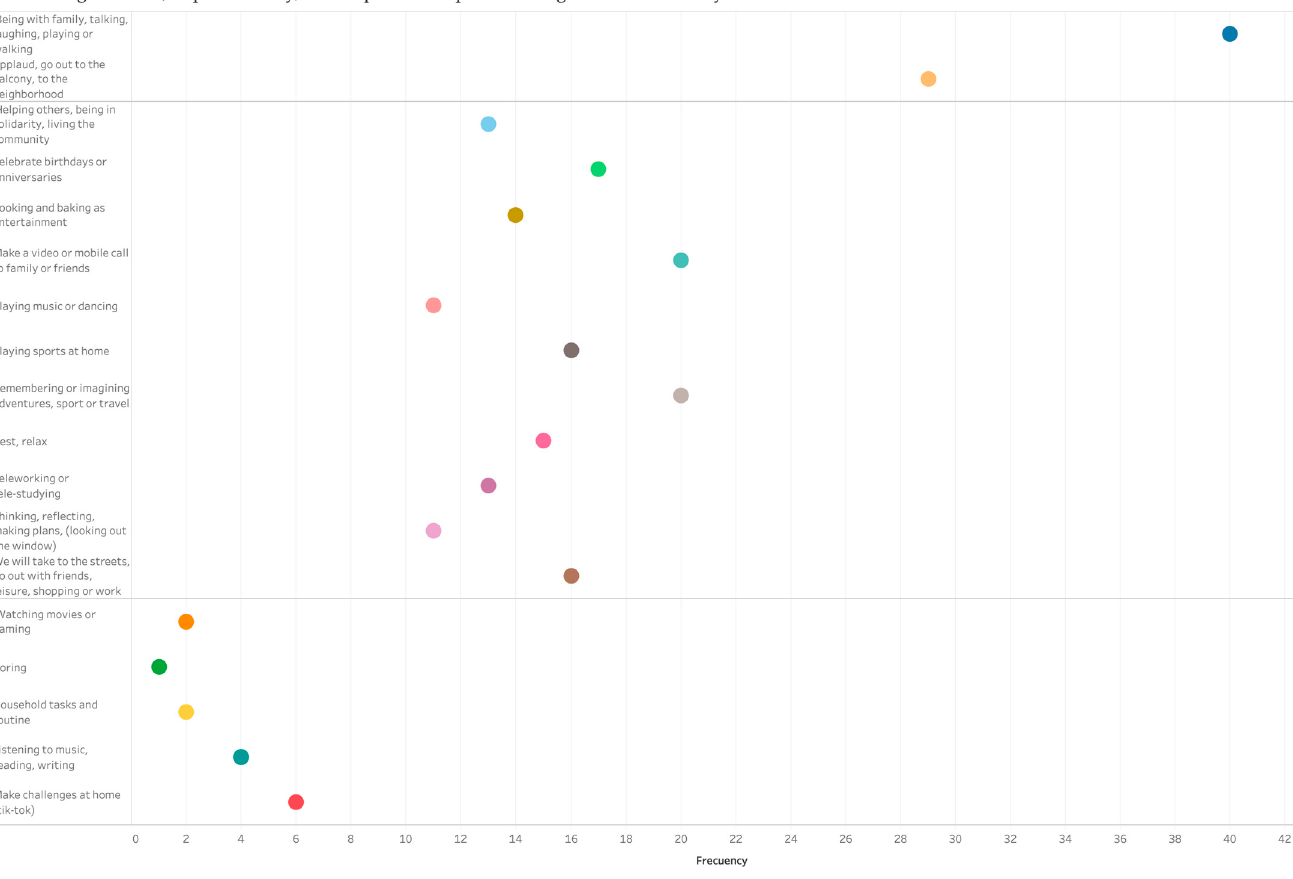
Figure 9. Group of communicative resources with de-stressing components.